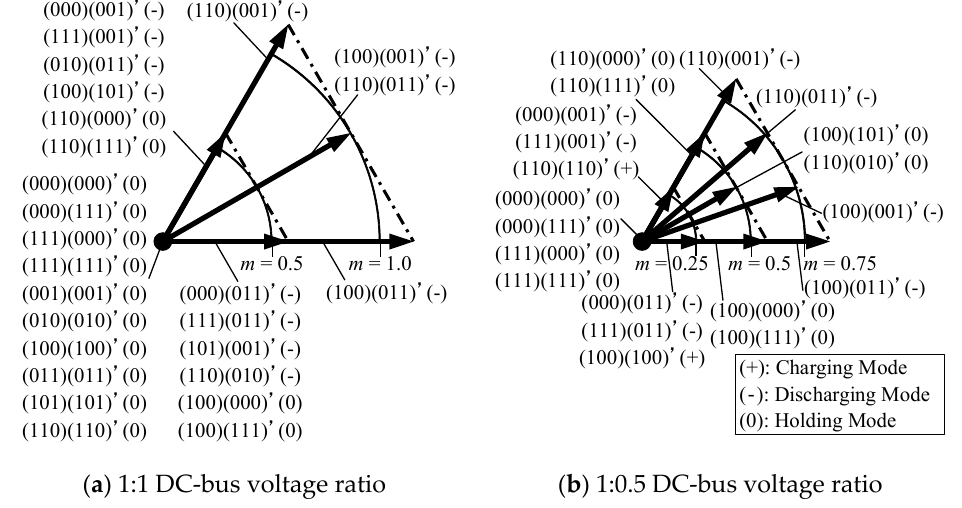
Figure 3. Redundant switching states and capacitor charging and discharging modes.